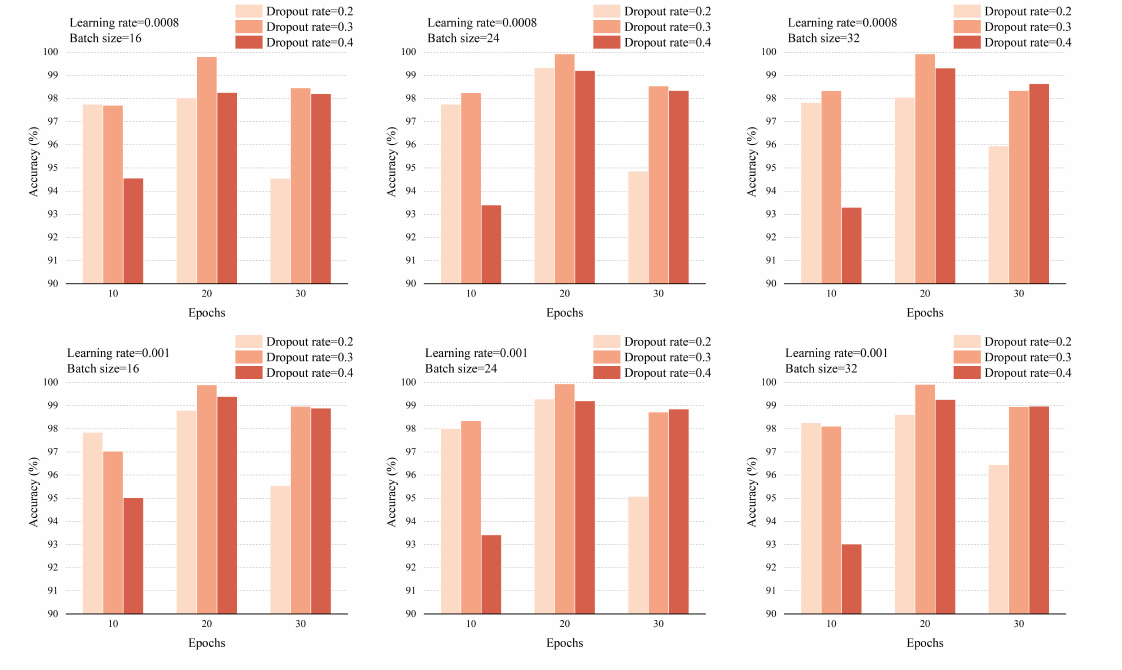
Figure 4. The adjustment and evaluation of the